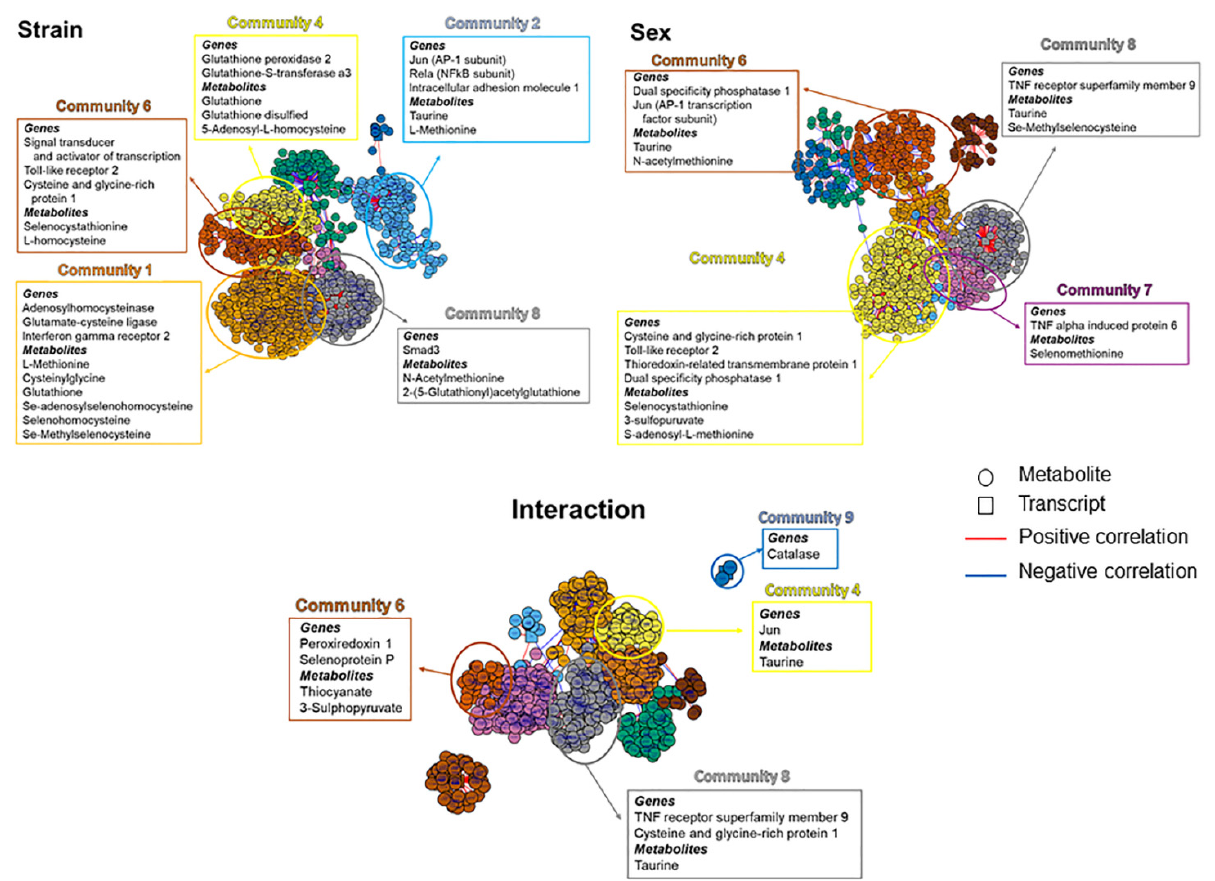
Figure 6. xMWAS analysis for interactions between transcriptomic and metabolomic data. Transcripts associated with inflammation and oxidant/antioxidant pathways within specific communities were identified, and associated metabolites were searched using enriched data sets.